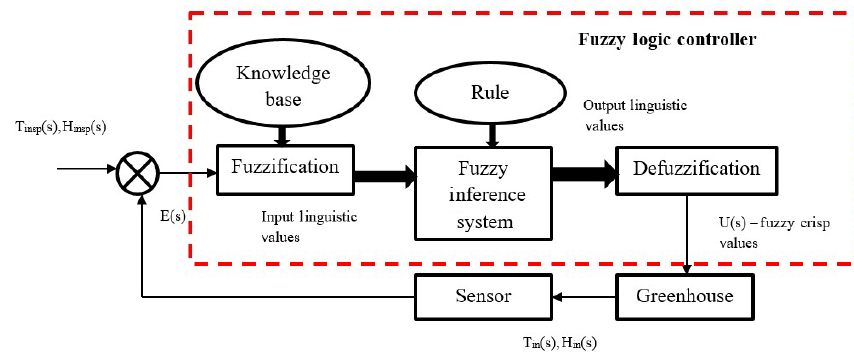
Figure 11. Closed-Loop Feedback system for Greenhouse using Fuzzy Logic Control.